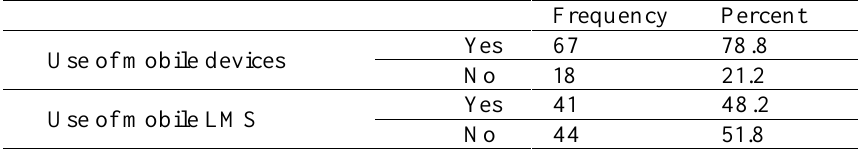
Number of Participants Using Mobile Devices and Mobile